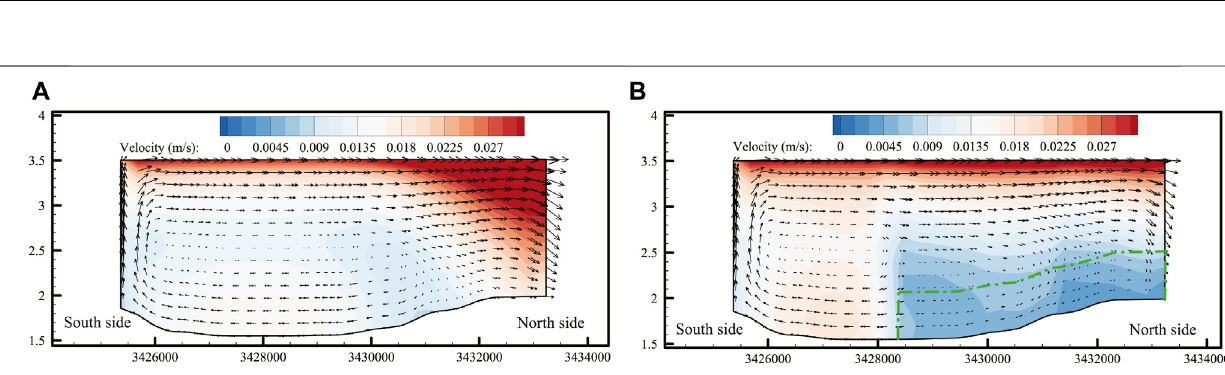
Frontiers in Environmental Science |